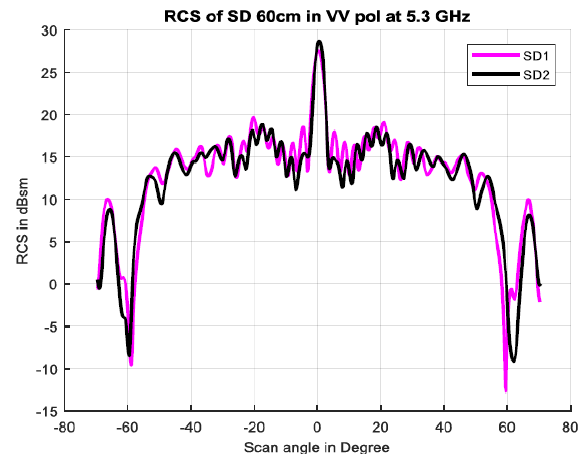
Figure 6(a): Plot of measured RCS values of SD_60cm_1,